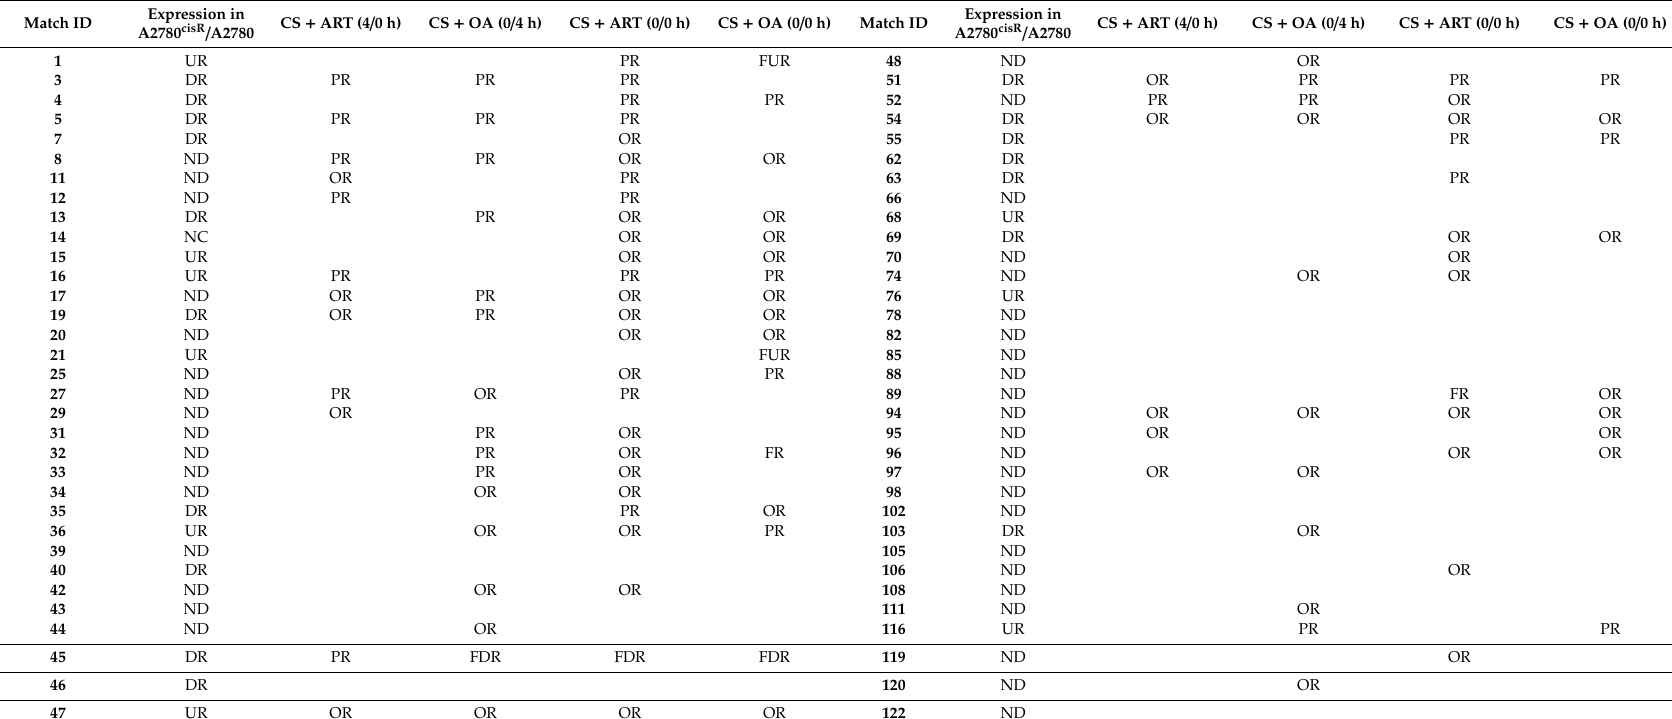
Table 7. List of protein expressions in A2780, compared to A2780 cisR using A2780 as